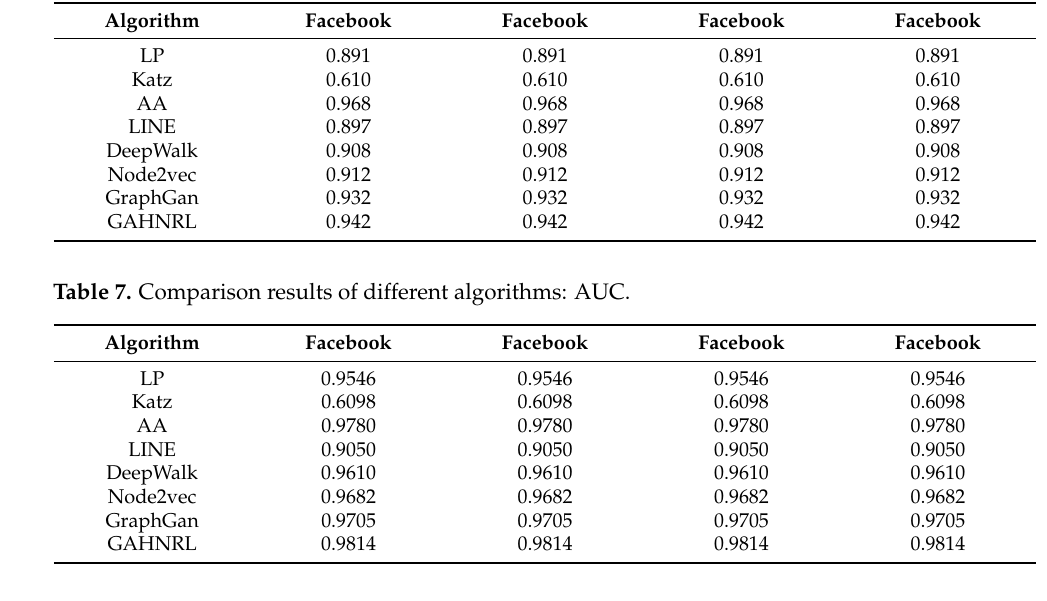
Table 6. Comparison results of different algorithms: accuracy.